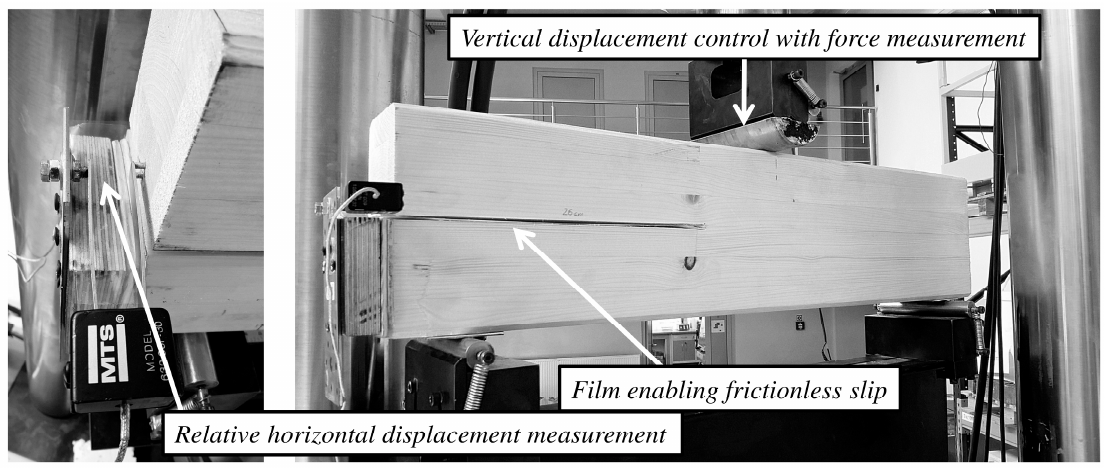
Figure 2. Pre-cracked beam—laboratory setup.